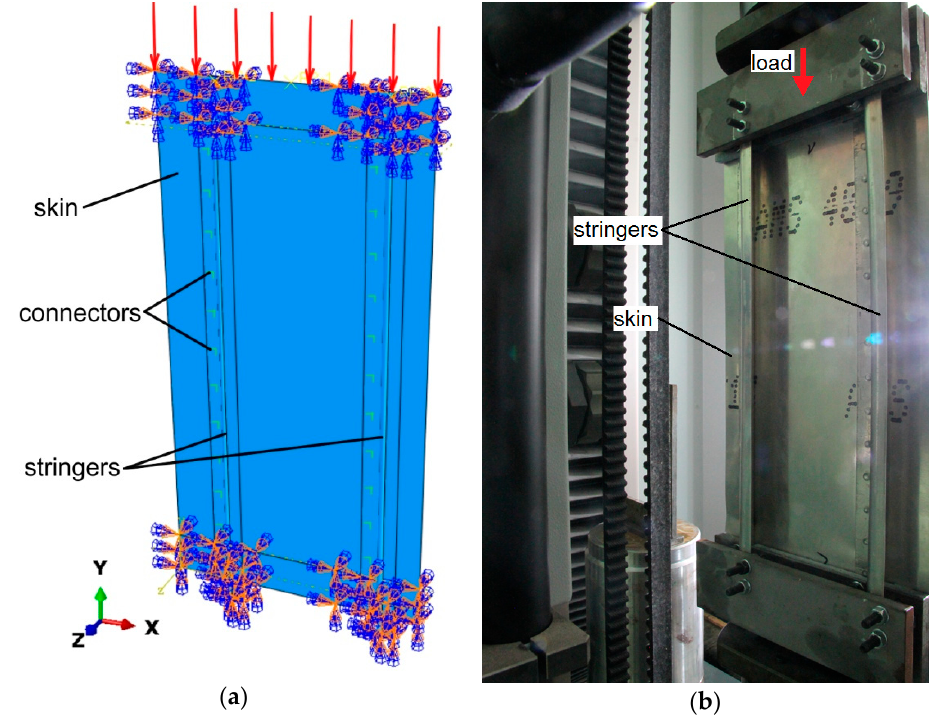
Figure 2. The boundary conditions on the model of panel compression analyzed ( a ) and a panel attached to the measuring stand ( b ).